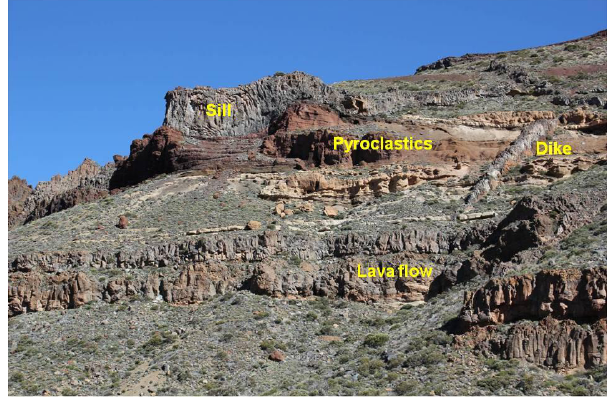
Fig. 2. Small shield volcano, the Holocene lava shield Skjaldbreidur in Southwest Iceland. View looking east, the top of the lava shield is at 1060 m a.s.l. and rises here some 700 m above its surroundings. The shield is composed almost exclusively of thin (0.5-2 m thick) pahoehoe flow units with little or no scoria at the contacts between the layers.